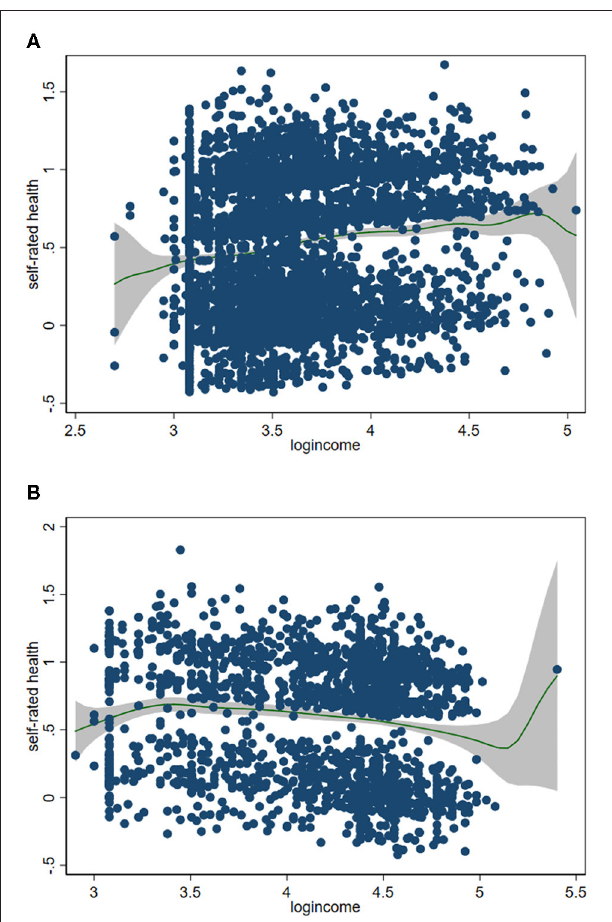
FIGURE 1 | Relationship between absolute income and self-rated health in urban older populations (A) and rural older populations (B) a,b . a Adjusted for age, gender, marital status, education, chronic disease, activities of daily living, personality trait, psychological distress and relative deprivation index. b The absolute income was transformed using logarithmic